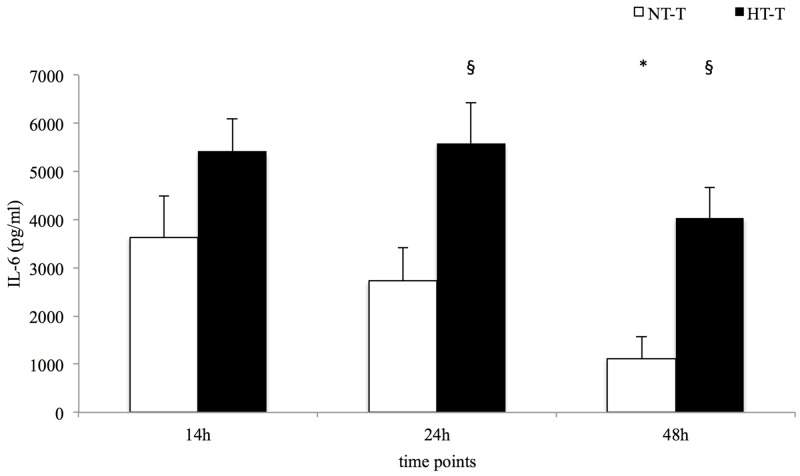
Local IL-6 concentrations.Statistical significance p = <0.05 (* from baseline, § NT-T vs. HT-T).